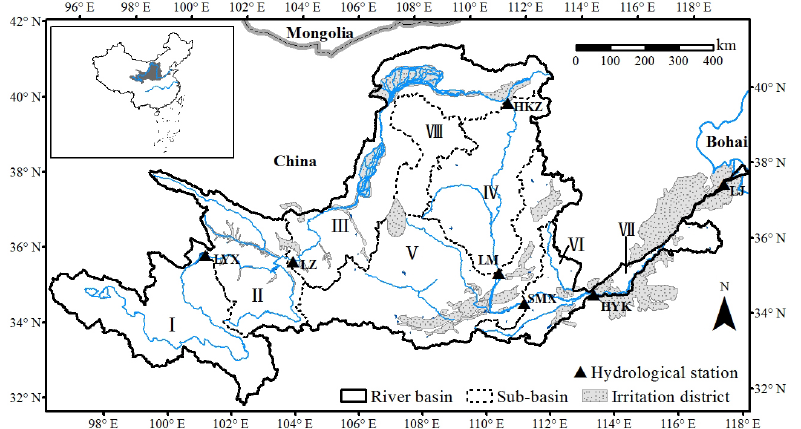
Figure 1. The Yellow River (YR) basin, the eight sub-basins, and location of Longyangxia (LYX), Lanzhou (LZ), Hekouzhen (HKZ), Longmen (LM), Sanmenxia (SMX), Huanyuankou (HYK), and Lijin (LJ) hydrological stations. The insert panel shows the location of the YR basin in